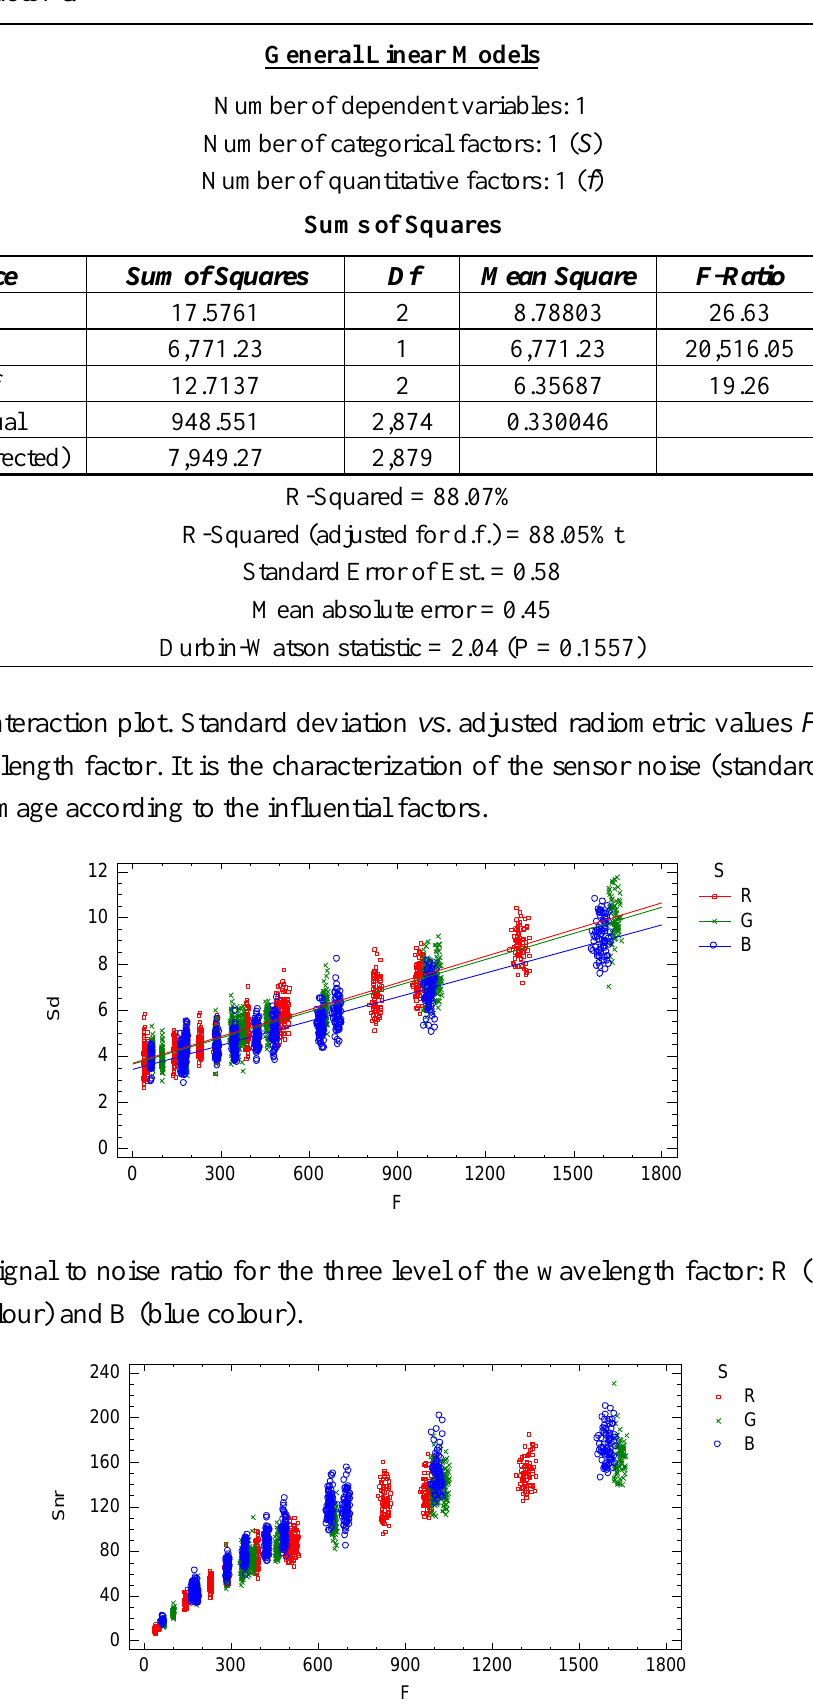
Table 5. Resulting ANOVA table of the sensor noise model without the effect of the sequential factor t .